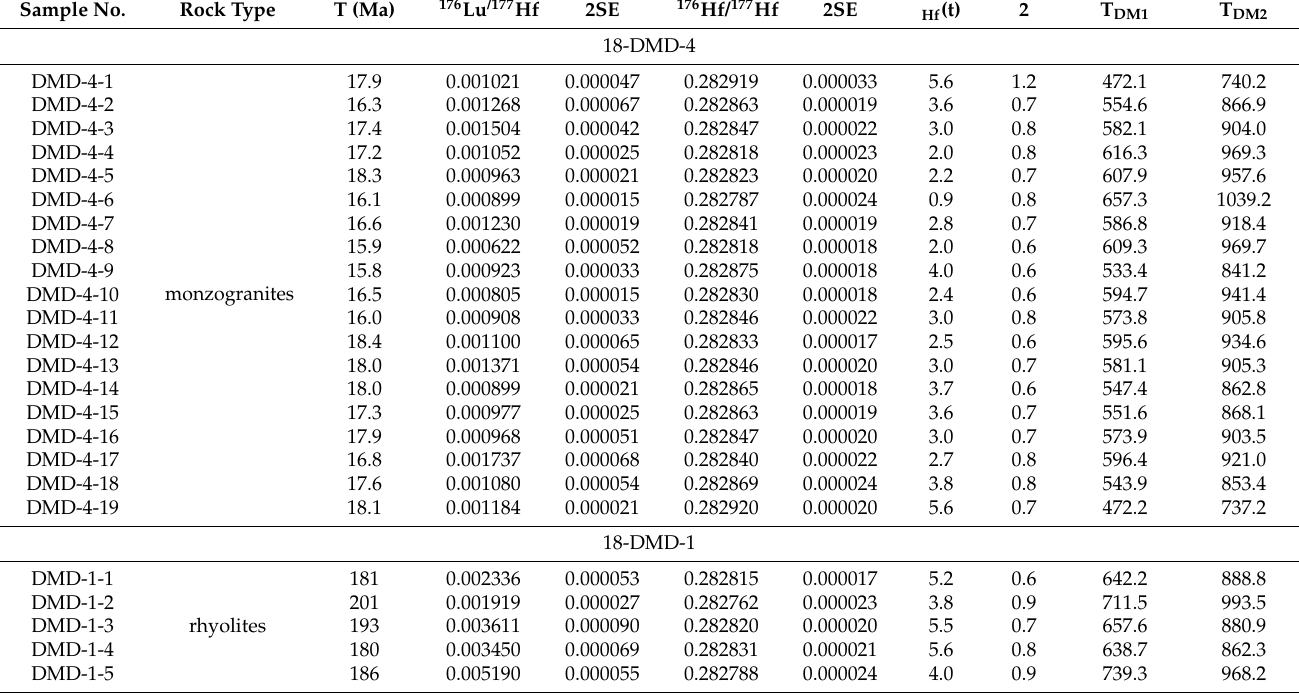
Table 3. Hf isotopic compositions of samples from the Demingding